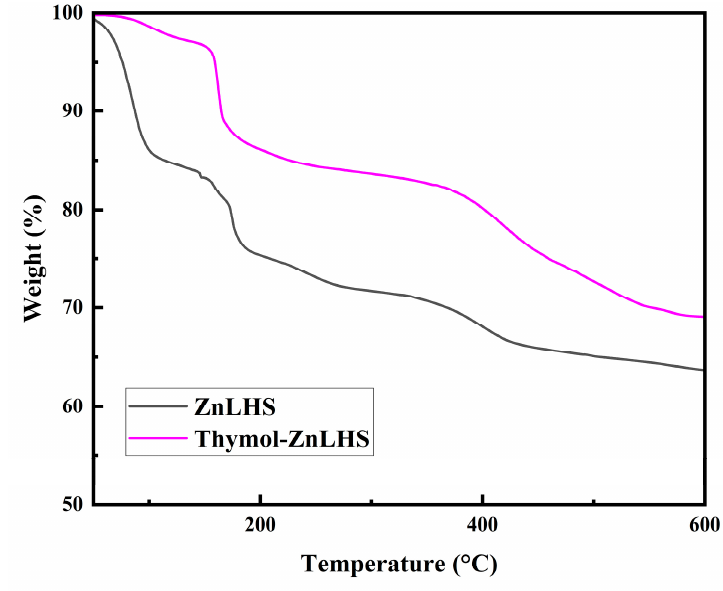
Figure 5. Raman spectroscopy of thymol, ZnHSL, and thymol–ZnHSL.